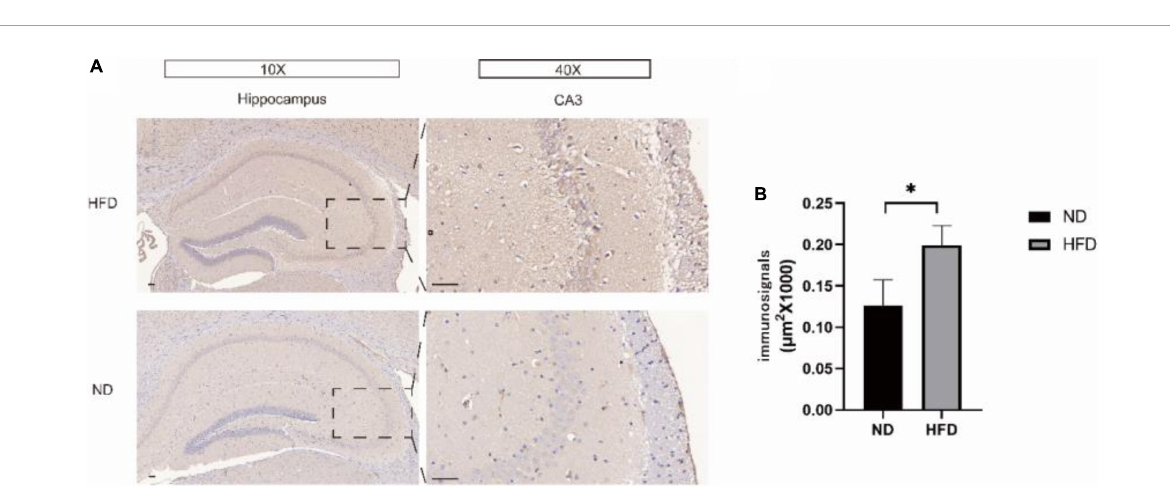
FIGURE6 (A) Hippocampal immunohistochemical staining using an antibody against A β 42 was performed to detect the A β 42 load in hippocampal slices from the ND group and HFD group. The right panel shows representative A β 42 plaque staining in region CA3. (B) Immunohistochemical analysis of A β 42 protein expression. Significant differences compared with the ND